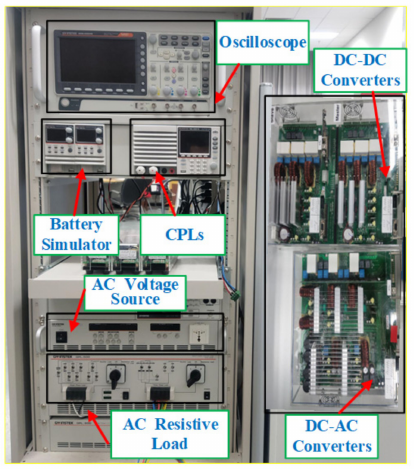
Figure 10. AC/DC Hybrid Microgrid experimental platform.